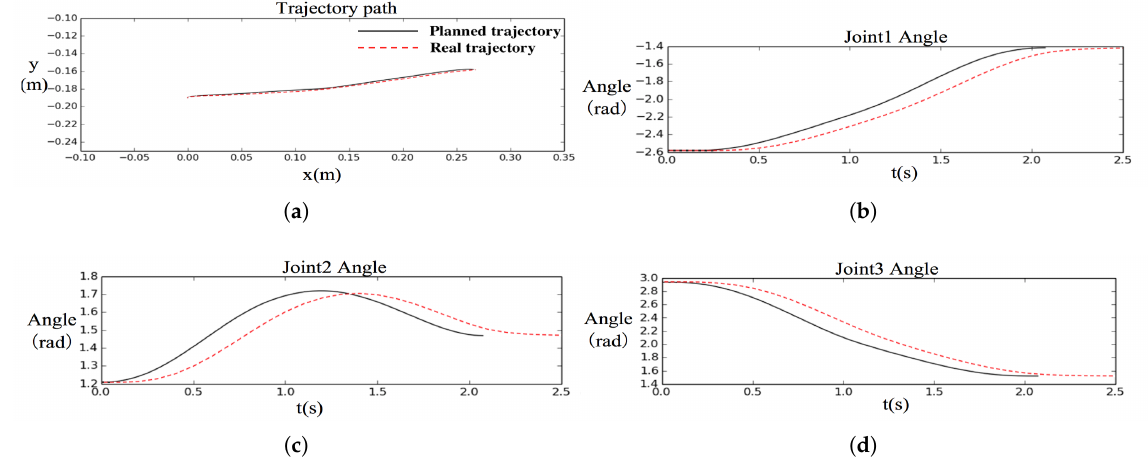
Figure 7. Tracking result of the proposed time-differential filtering-based controller. ( a ) Trajectory path; ( b ) joint1 angle; ( c ) joint2 angle; ( d ) joint3